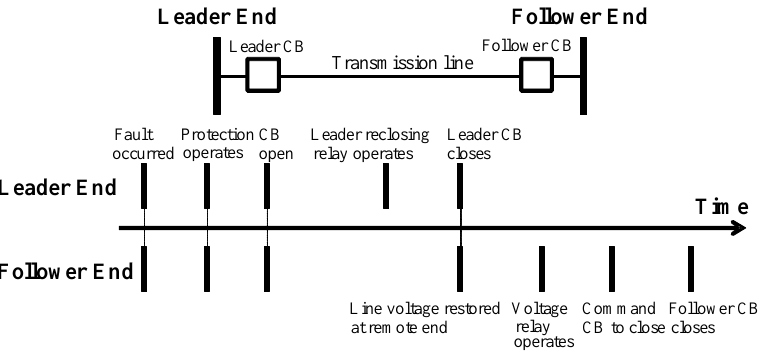
Figure 1. Sequence of the leader-follower auto-reclosing scheme.